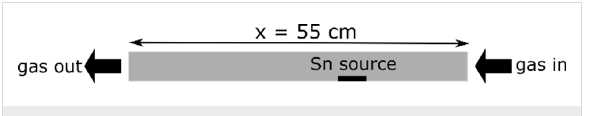
Figure 1: Simulation setup of the quartz tube (Ø 5